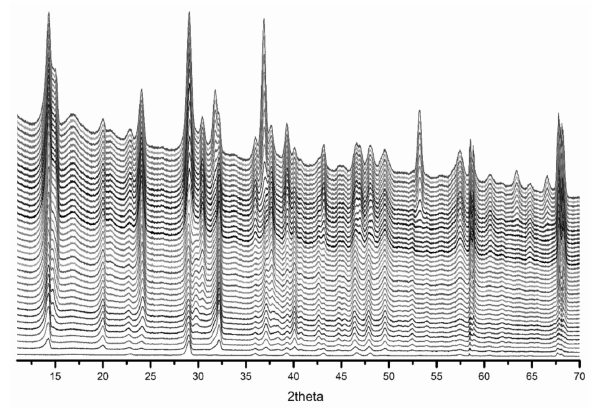
Figure 2. Raw data of HT-XRPD in-situ measurement (Ramp#3).